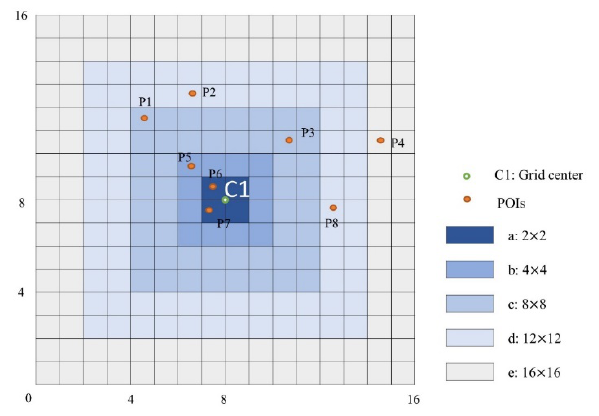
Figure 6. Principle of spatial correlation coefficient of features. cells. C1 is the center point of the grid, and the ring grid area of